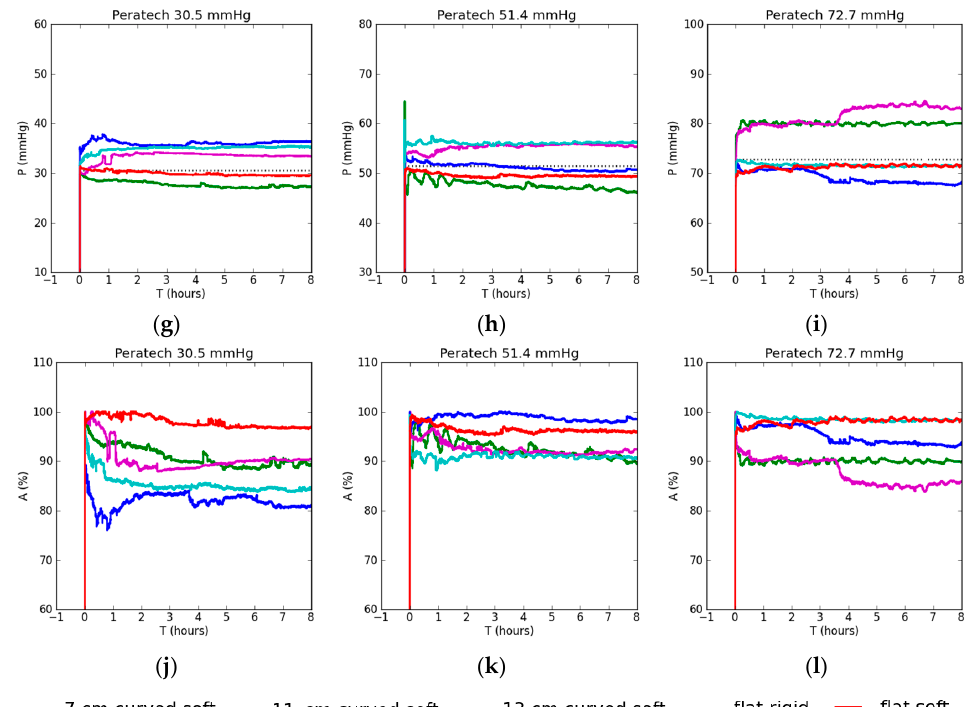
Figure 4. Static testing results using Peratech sensor with applied pressure shown in the title: ( a – c ) sensor output voltage reading; ( d – f ) sensor pressure reading when flat rigid calibration was used for all tests; ( g – i ) sensor pressure reading when sensor was recalibrated before each test. Dotted lines show corresponding applied ‘gold standard’ pressures; ( j – l ) accuracy of the sensor pressure reading.